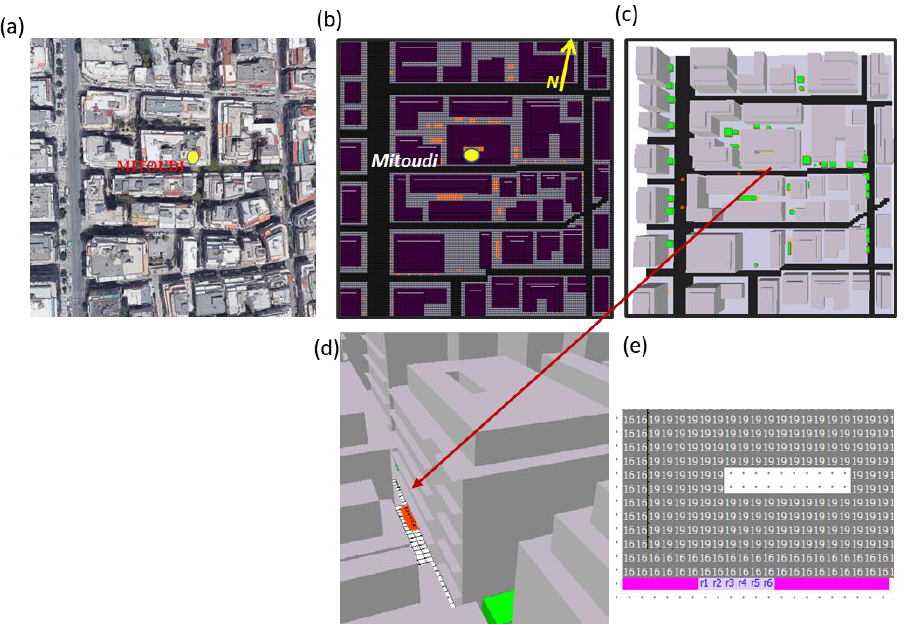
Figure 6. ( a ) Google Earth image of the urban district and indication of the location of the examined building ( b ) plan and ( c ) 3D view of the ENVI-met area input file, ( d , e ) indication of the receptor files, placed in front of the examined building unit to extract the necessary simulation output.